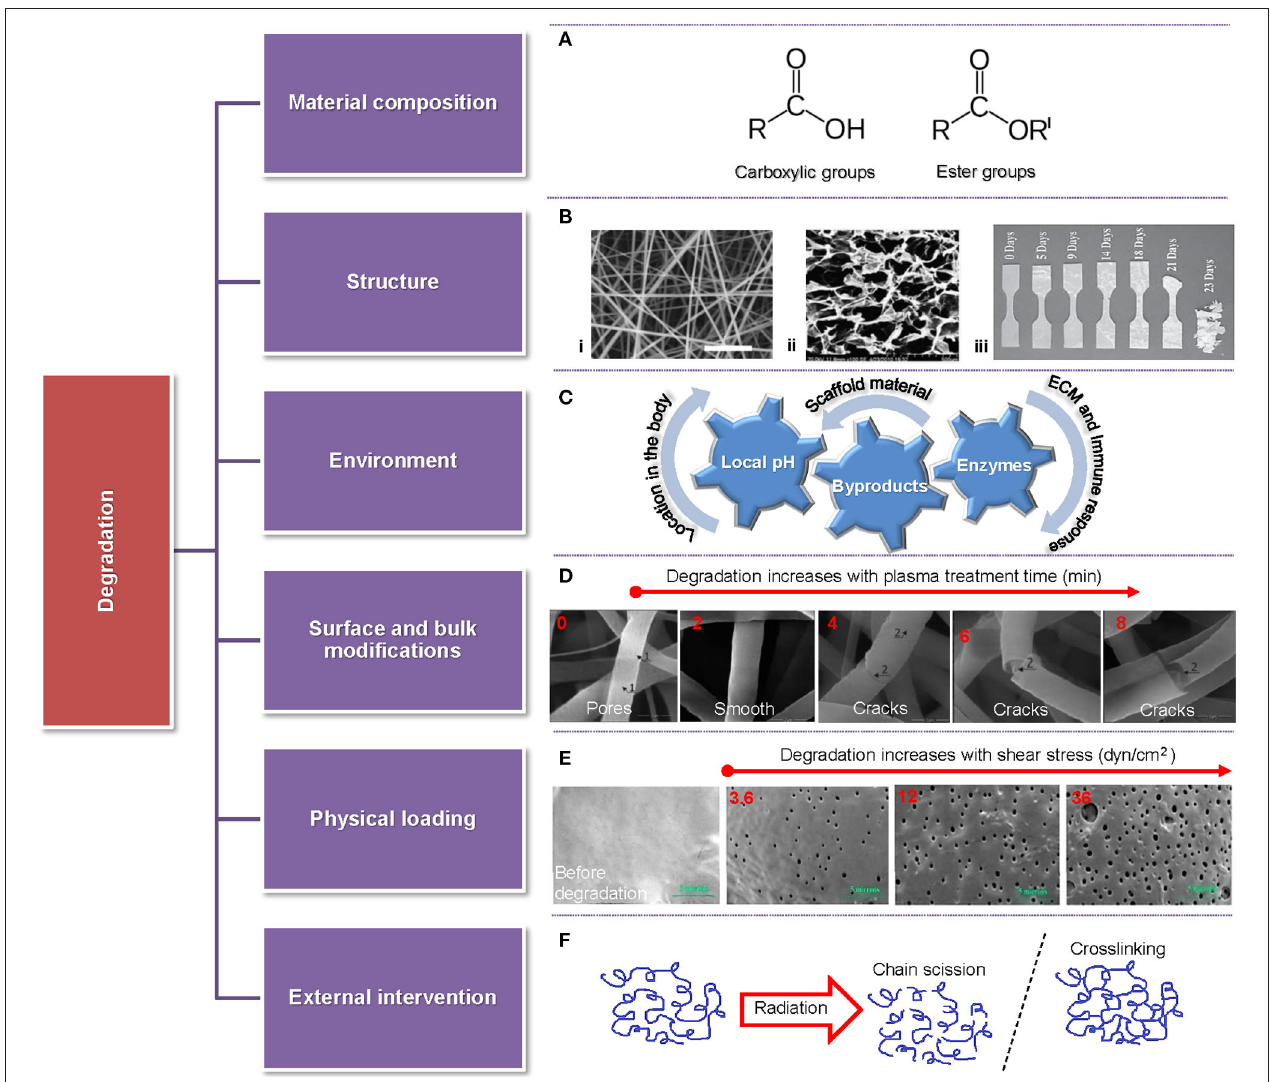
FIGURE 4 | Overview of parameters affecting the degradation rate of scaffolds accompanied by representative examples. (A) Highly reactive functional groups attacked by water molecules. (B) Different scaffold structures: (i) fibrous (Pu and Komvopoulos, 2014), (ii) porous (Han et al., 2014), and (iii) solid (Weir et al., 2004). (C) Various environmental factors (local pH, byproducts, and enzymes) affecting scaffold degradation. (D) Fiber morphology vs. time of plasma treatment showing fiber degradation after a short treatment time and fiber cracking and breakage after long treatment time (Bolbasov et al., 2018). (E) Comparison between a fresh sample and samples degraded for 28 days in PBS at 32 ◦ C for shear stress increasing from 3.6 dyn/cm 2 (left) to 36 dyn/cm 2 (right) (Zheng et al., 2017). (F) Schematic of chain scission and crosslinking induced by